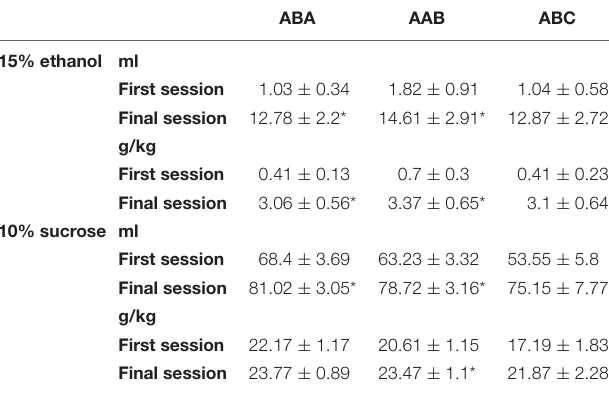
TABLE 2 | Home cage consumption of 15% ethanol or 10%